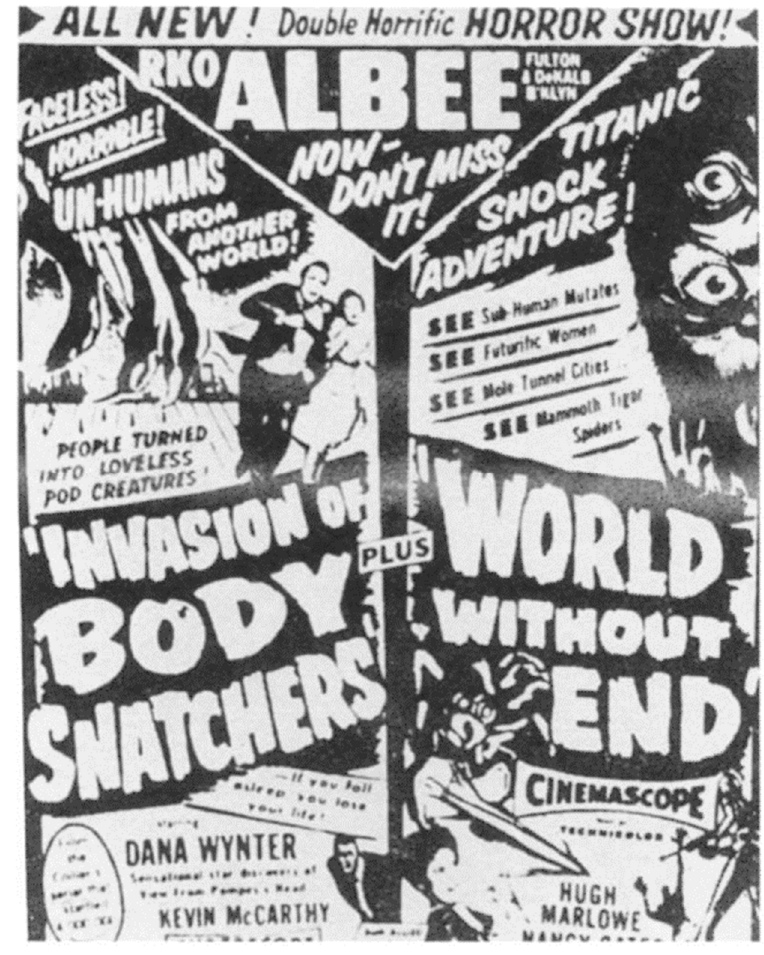
Figure 8. Advertisement for the Albee Theater, New York Journal-American, 28 March 1956, p. 24.